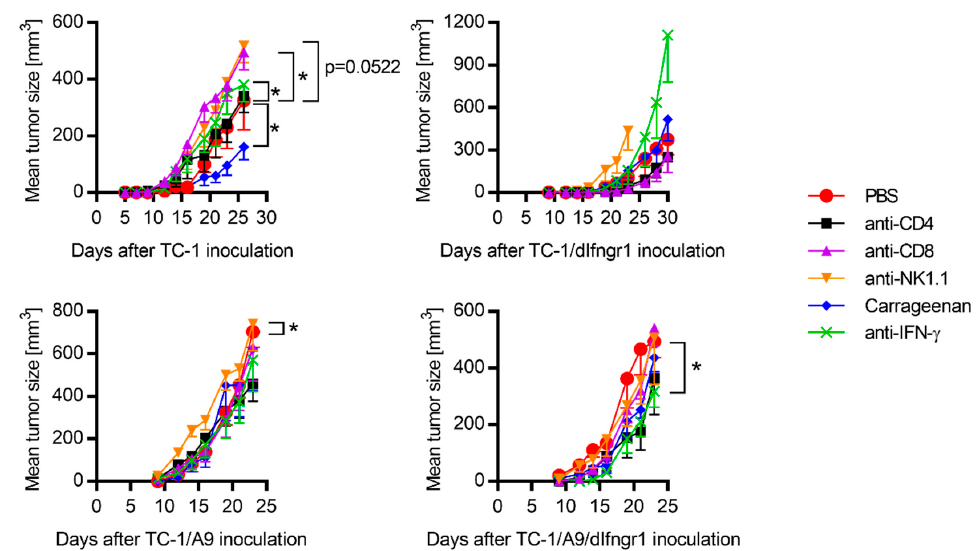
Figure 2. Mechanisms contributing to anti-tumor immunity. C57BL/6 mice ( n = 5) were s.c. injected with 3 × 10 4 tumor cells and treated with anti-cluster of differentiation (CD)4, anti-CD8, anti-natural killer (NK)1.1, and anti- interferon (IFN)- γ antibodies or carrageenan. Phosphate-buffered saline (PBS) was injected as a negative control. Bars ± SEM; * p < 0.05.